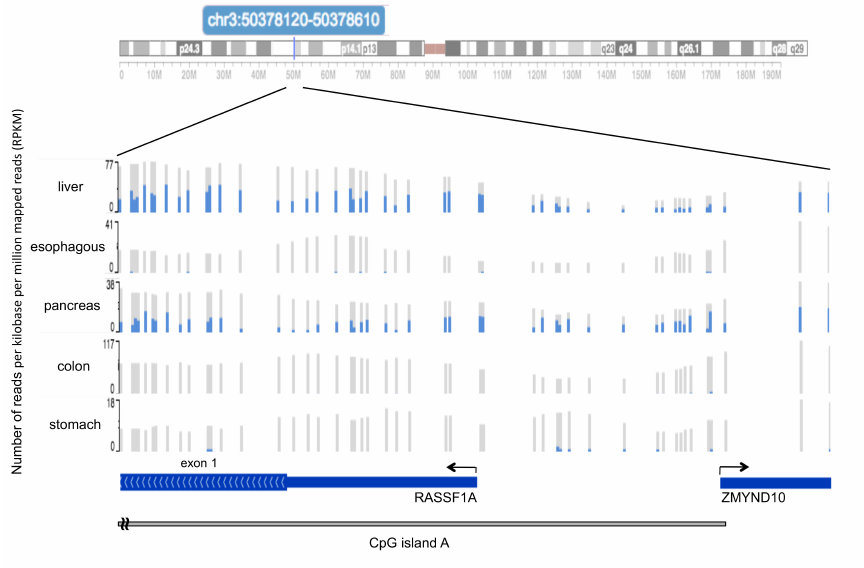
Figure 2. Methylation level of 48 CpGs in the promoter and first exon of RASSF1A in five normal tissue types. Results of bisulfite DNA sequencing on liver, esophagus, pancreas, colon, and stomach tissues samples taken from a 34-year-old healthy subject. The grey / blue vertical bars represent 48 CpGs overlapped to the promoter of RASSF1A and partially to first exon and CpG island A. For each CpG, the blue line is the number of reads for the 5mC and grey is the total number of reads (number of reads per kilobase per million mapped reads, RPKM) obtained by bisulfite DNA sequencing. The ratio